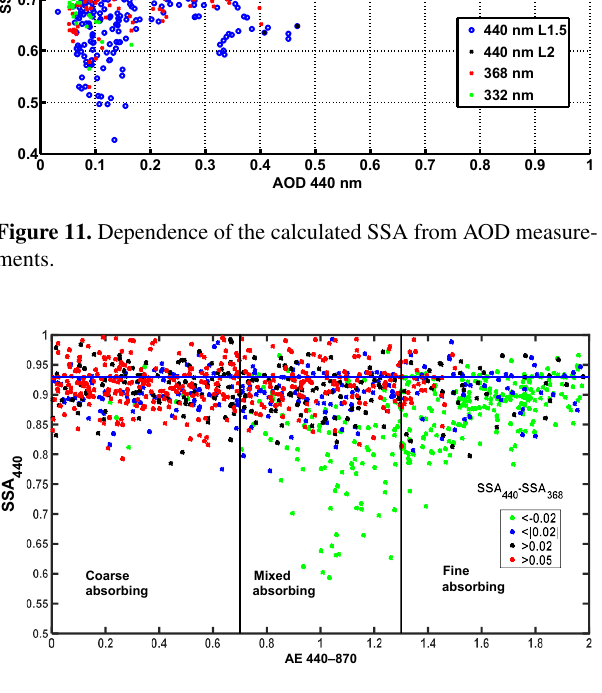
Figure 12. Daily average SSA 440 (CIMEL) versus AE ( 440 − 870nm ) . Colors represent different bins of the spectral differences of SSA 440nm − SSA 368nm